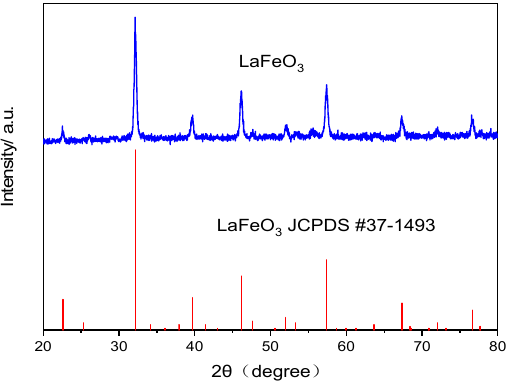
Figure 2. XRD patterns of LaFeO 3 sensing electrode material.